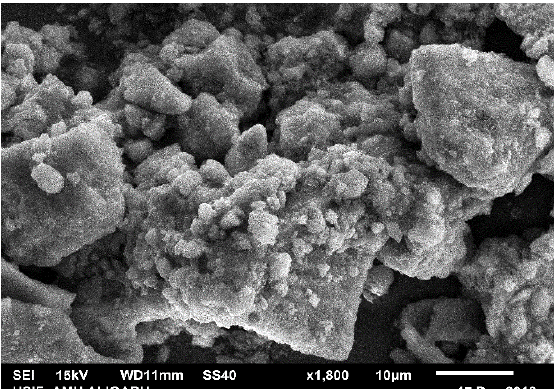
Figure 3. Fourier Transform Infrared Spectroscopy (FTIR) spectrum of Fe-Mg Binary Oxide Na- noparticles.